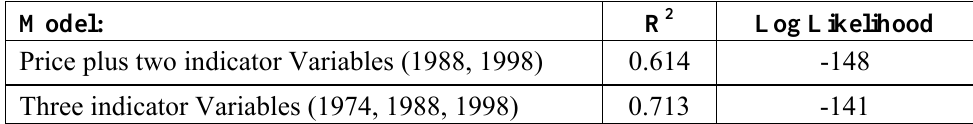
Table 11. Comparison of Four versus Three Cycle Hubbert